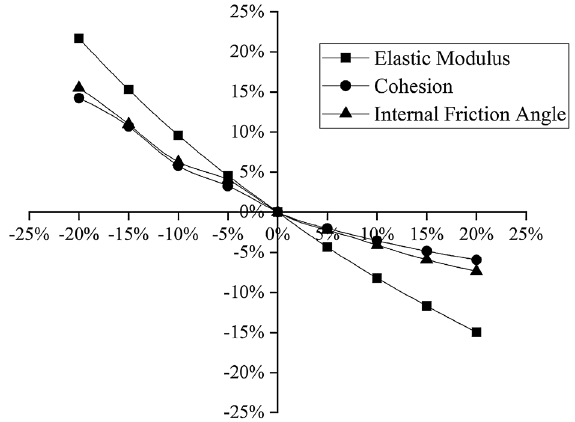
Figure 6. Relationships between the soil parameters and the horizontal displacement of the pile